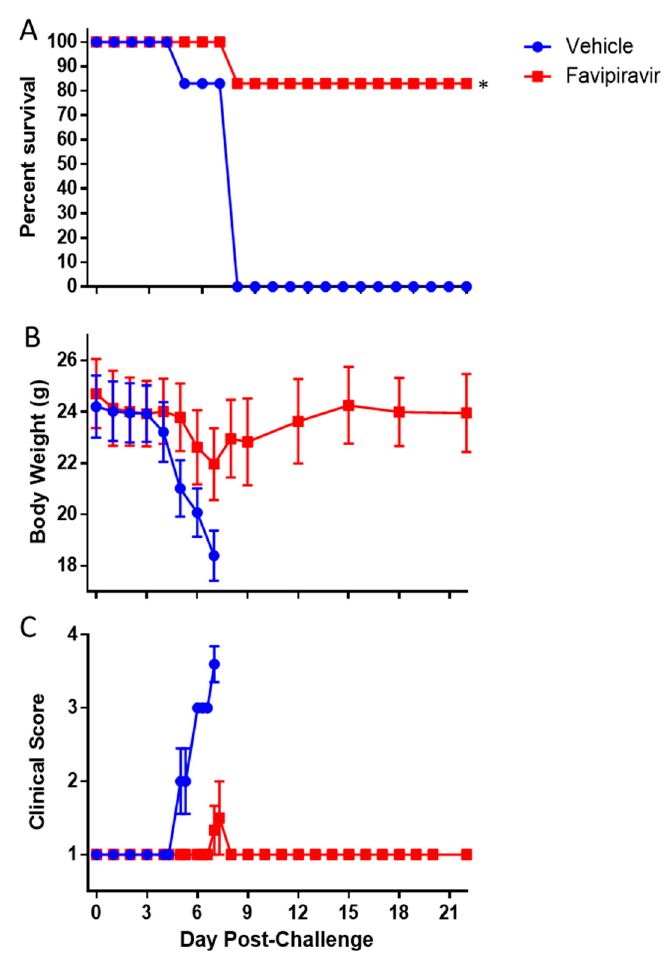
Figure 8. Efficacy of Favipiravir against EBOV in IFNAGR mice. Mice were challenged with 1.0 × 10 2 pfu of EBOV then treated with 150 mg/kg of favipiravir twice daily for 8 days. The mice were observed for survival ( A ), body weight loss ( B ), and clinical score ( C ). The asterisk indicates statistical significance ( p = 0.015, Fisher’s Exact Test). The bars indicate standard error.